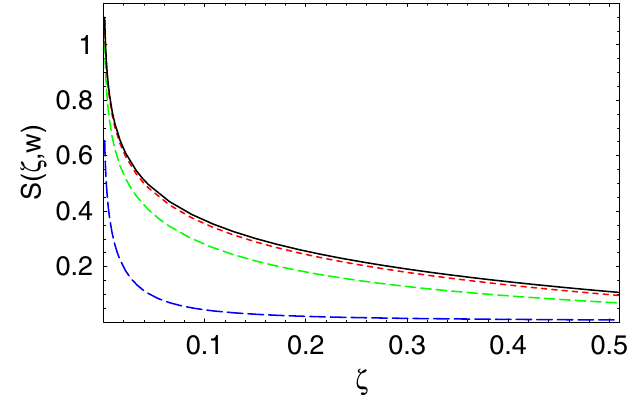
FIG. 5. (Color) Function S (45) for a square chamber versus the ratio (cid:14) of the beam size to the chamber size a at three different values of w (cid:5) (cid:10)a=(cid:5) (cid:5) 0 ; 1 ; 10 (short-dashed, dashed, and long- dashed curves). The solid curve shows the analytical relativistic limit ln (cid:2) 1 =(cid:14) (cid:3) = (cid:2) 2 (cid:5) (cid:3)